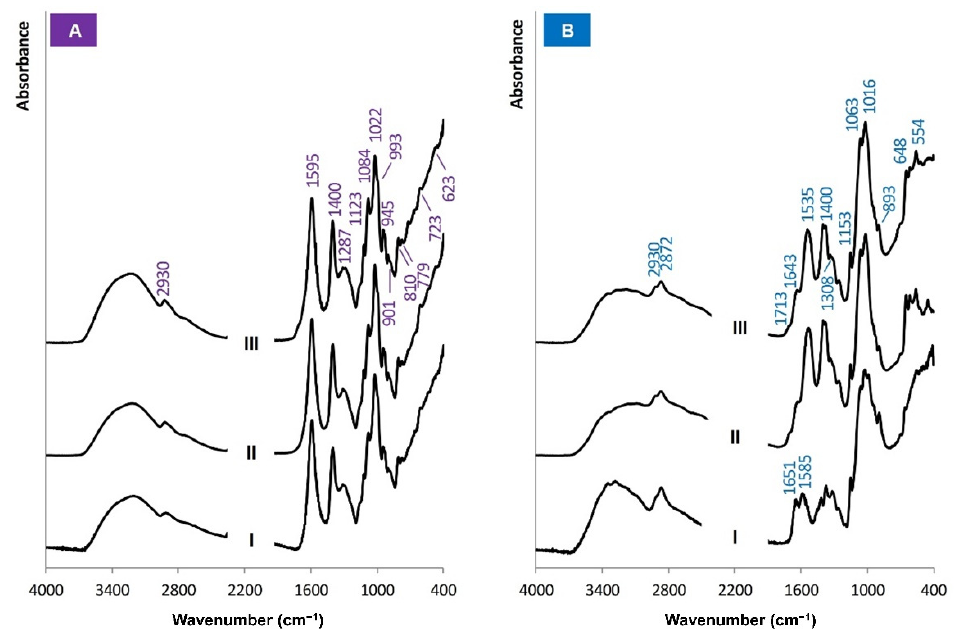
Figure 1. FT-IR spectra of biopolymers: ( A -I) Na-alginate (commercial), Na-alginate film prepared from the solution ( A -II) before and ( A -III) after autoclaving, ( B -I) chitosan (commercial), chitosan film prepared from the solution ( B -II) before and ( B -III) after autoclaving.